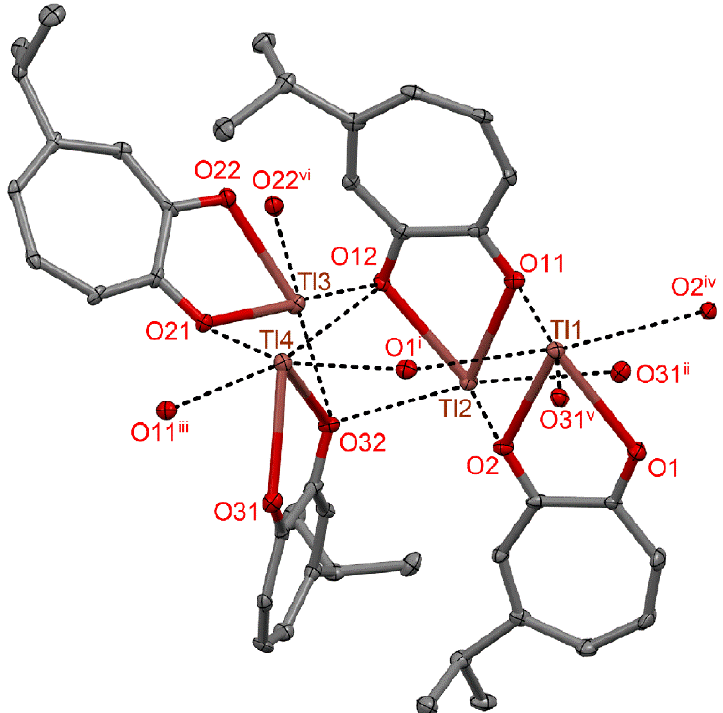
Figure 7. Asymmetric unit of 3 with intermolecular contacts between Tl(hino) molecules (atoms shown as 50% ellipsoids; hydrogen atoms were omitted for clarity).